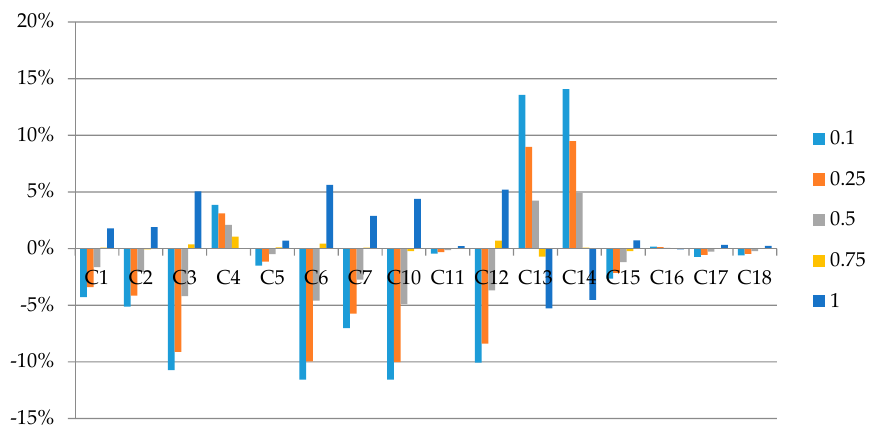
Figure 9. The impact of technological factors on the other factors.